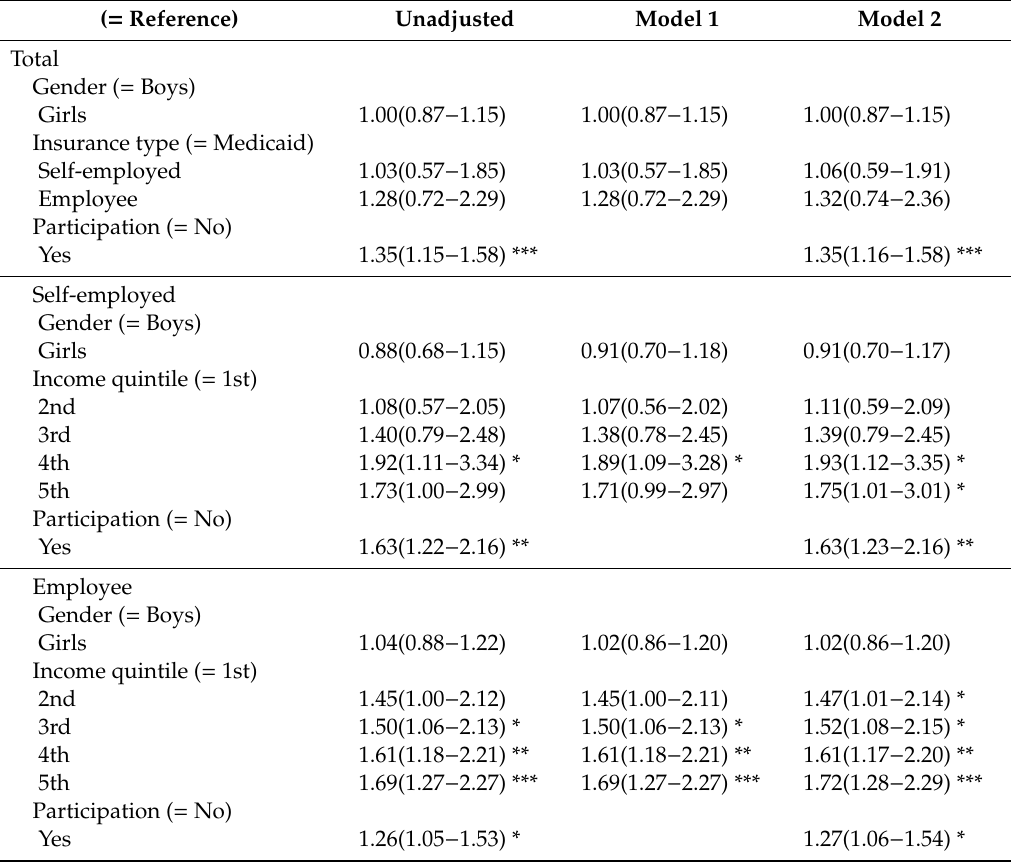
Table 3. Odds ratio (OR) and 95% confidence interval (CI) estimated from panel logistic regression models for dental sealant in the NHISS.